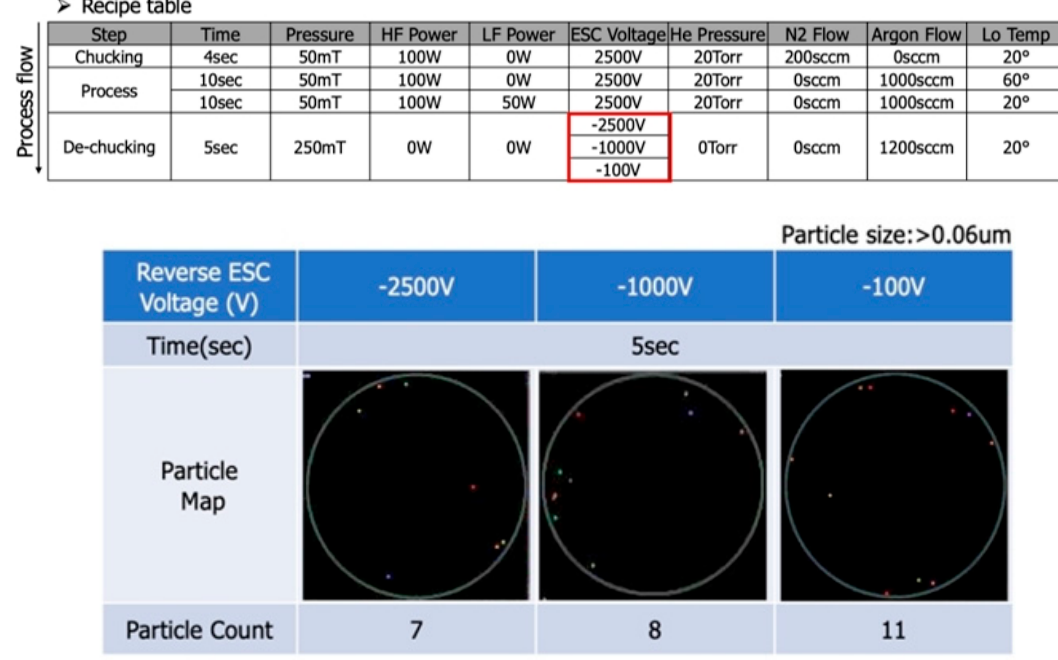
Figure 18. Particle distribution results under different reverse ESC voltages.